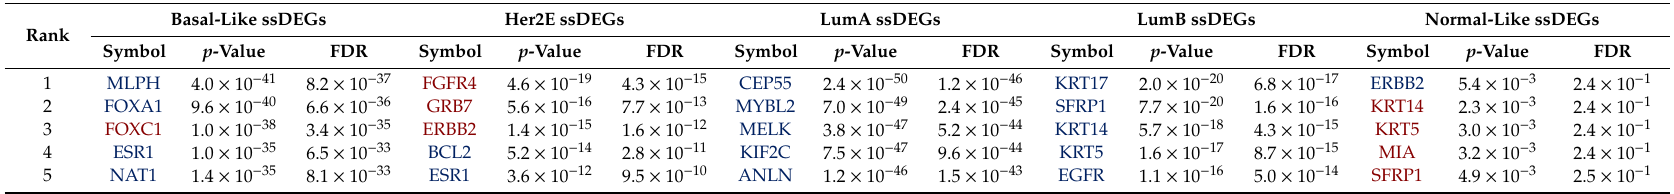
Table 1. Top ssDEGs for five